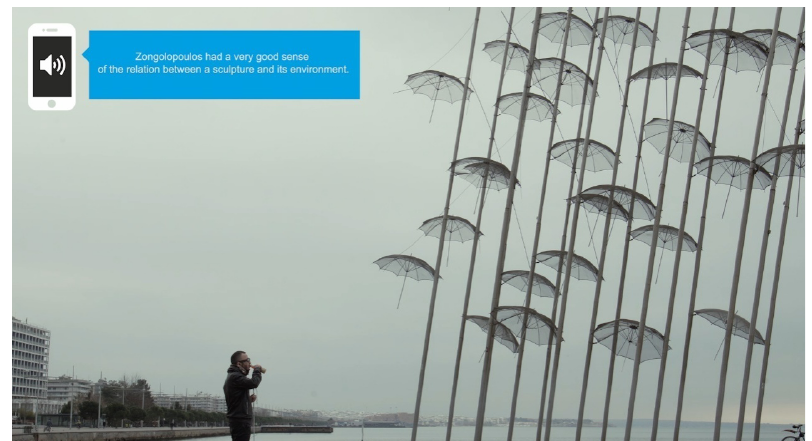
Usage of the e-Vision application (soundscape case), during an outdoor walk, near the “Zongolopoulos’ umbrellas” monument, by a visually impaired person. The blue textbox contains a sample of the message that is communicated to the